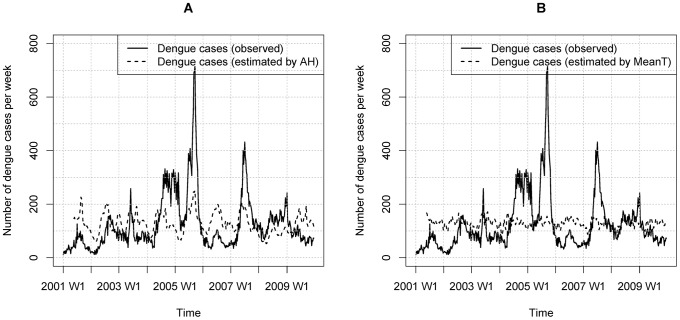
Weekly counts of dengue cases from 2001–2009.A: Observed dengue cases and number of fitted dengue cases estimated by the AH term in the DLNM model; B: observed dengue cases and number of fitted dengue cases estimated by the MeanT term.